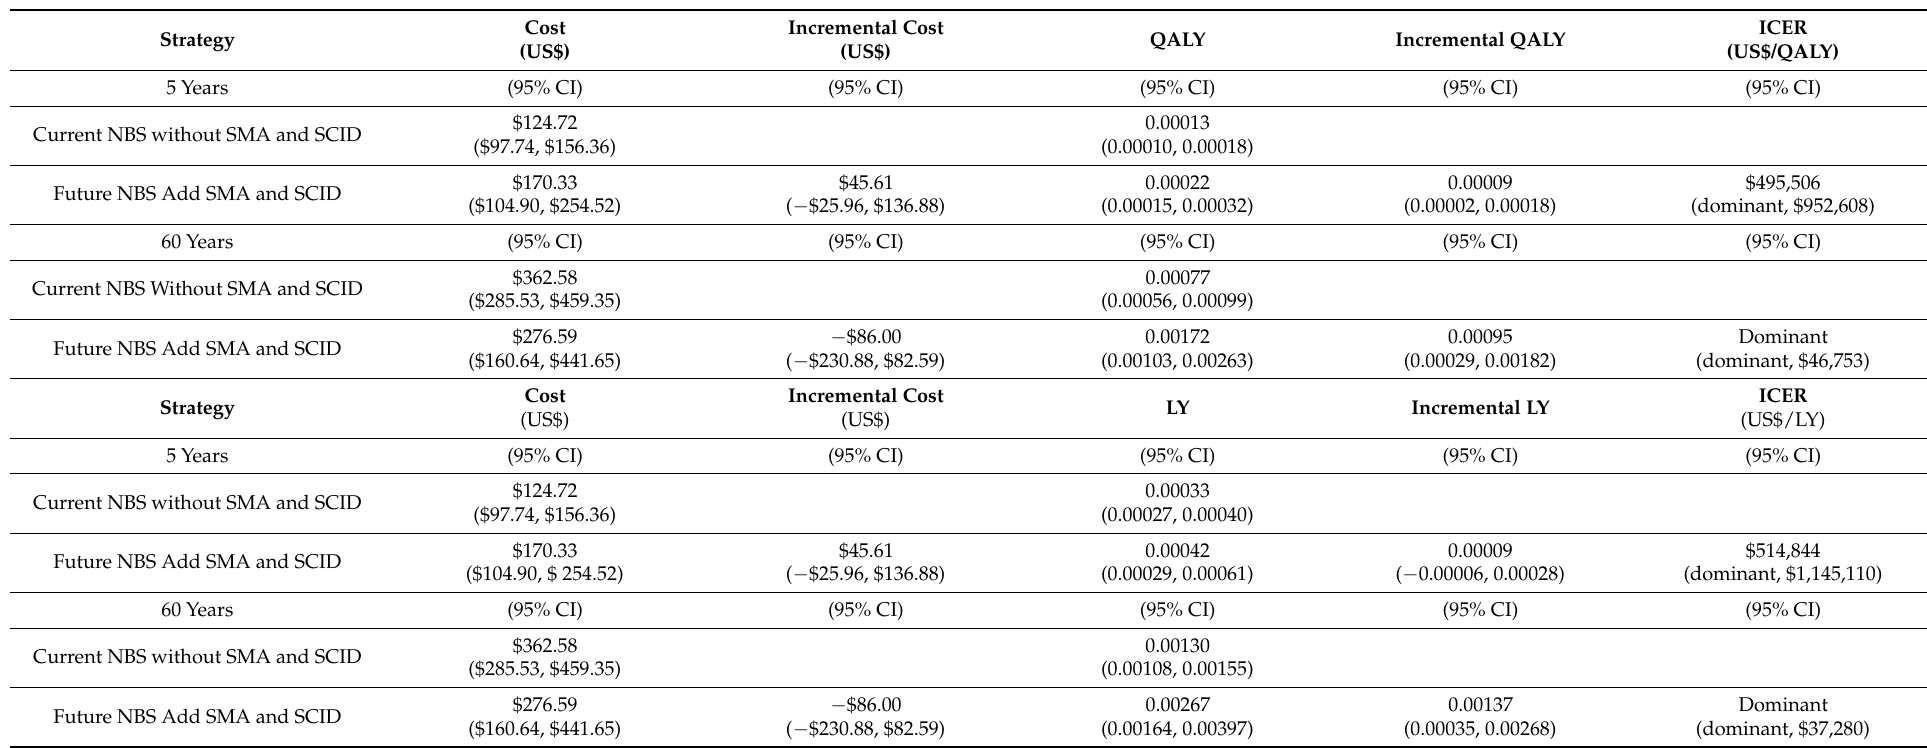
Table 1. Cost-effectiveness of a combined NBS for SCID and SMA treated with early HSCT and gene therapy over 5 and 60 years from the government’s perspective, discounted at 3% p.a. (US$